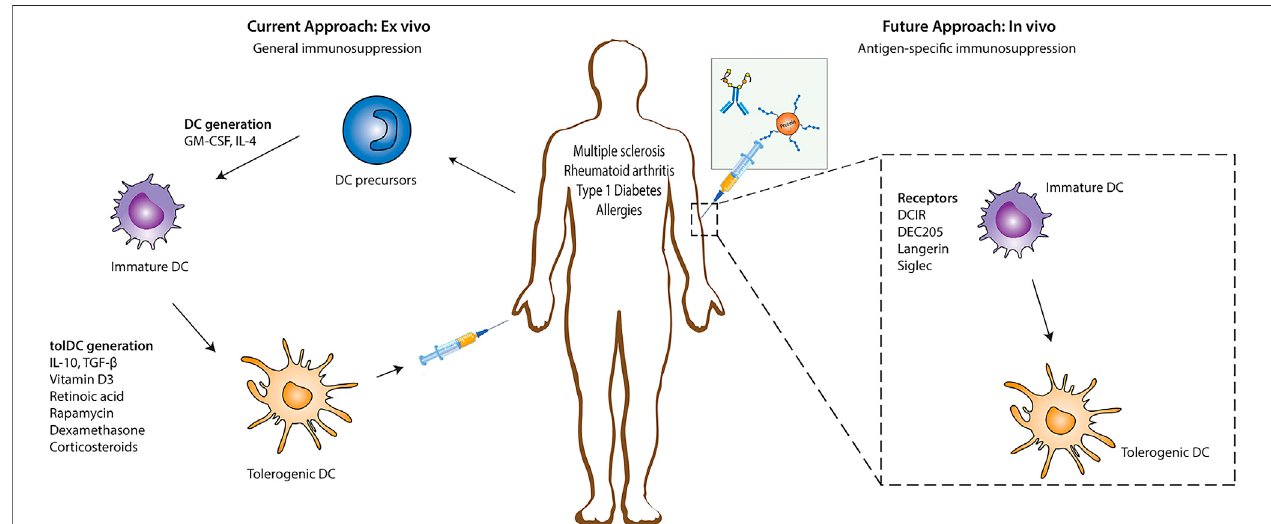
FIGURE 1 | Immune regulation strategy based on DC. Reprogramming DC to induce a tolerogenic phenotype to treat autoimmune diseases. Tolerogenic DC is mainly induced in vitro . First, DC precursor cells were isolated from bone marrow and stimulated to differentiate into immature DC (imDC). Then, immunomodulatory agents (such as vitamin D3, rapamycin, retinoic acid, and speci fi c cytokines) were added to induce the differentiation of imDC into tolerogenic DC. Subsequently, reinjecting intopatients tosuppress in fl ammation. Another strategy for inducing tolerogenic DC isdirectly targeting receptors on the DC surface (such asDEC205, langerin, and Siglec receptors). Reproduced with permission from (Castenmiller et al., 2021).